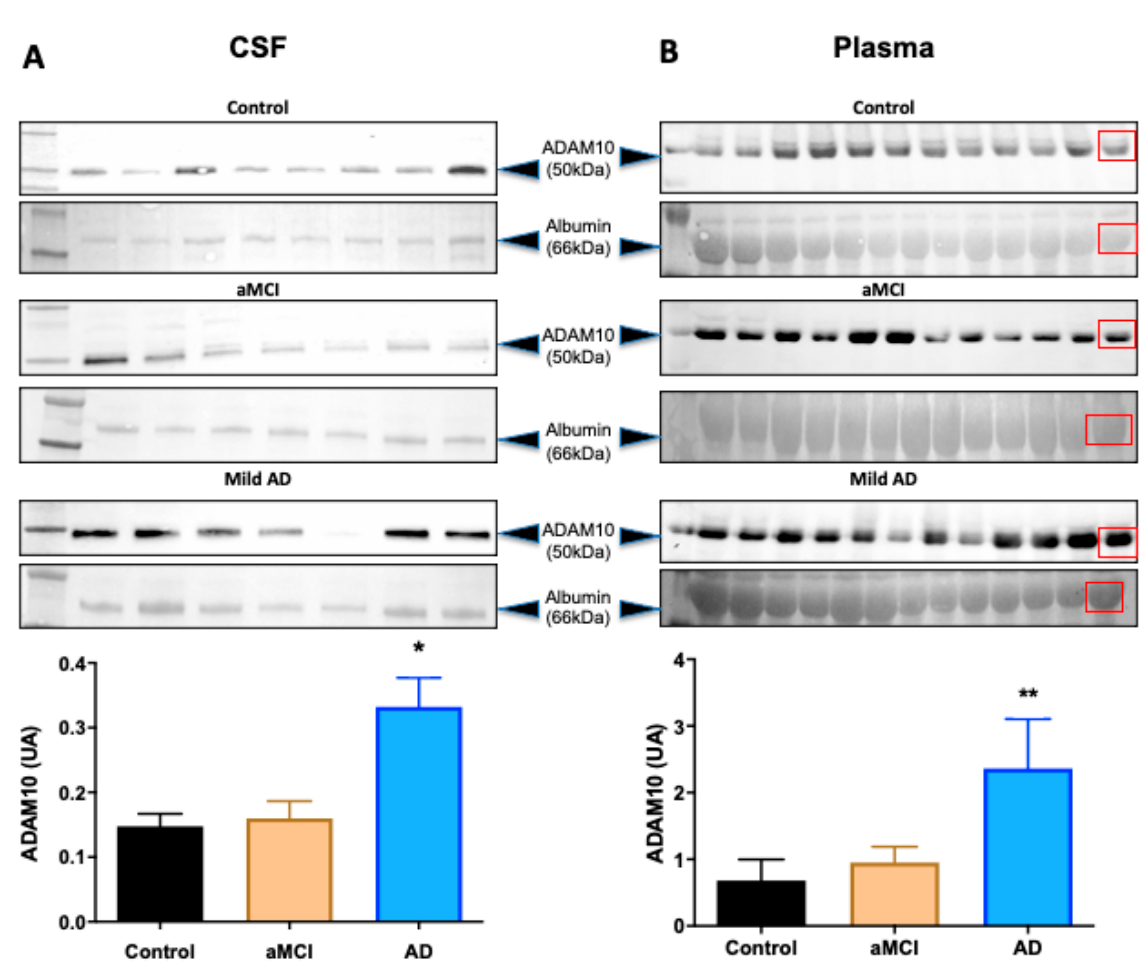
Figure 2. Western blotting assays and ADAM10 protein quantification in CSF and plasma. ( A ) Western blotting and quantification of CSF and ( B ) plasma samples from controls (cognitively healthy), aMCI and mild AD participants probed against anti-N-terminal ADAM10 antibodies, which recognized a 50 kDa form of the protein. Serum albumin (66 kDa) from all participants was used as load control for the quantifications. The last lanes of plasma membranes were loaded with young control samples (red squares). * p = 0 .02; ** p = 0.01 (control vs mild AD). One-Way ANOVA and Mann-Whitney test. Graph Pad Prism 8.